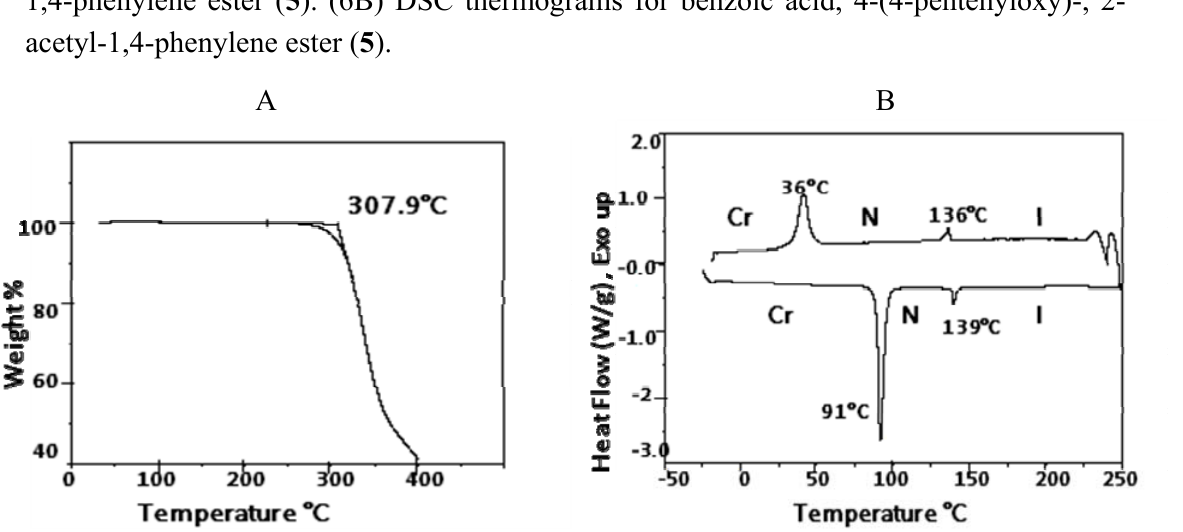
Table 2. Phase transition temperatures and enthalpy changes of compound